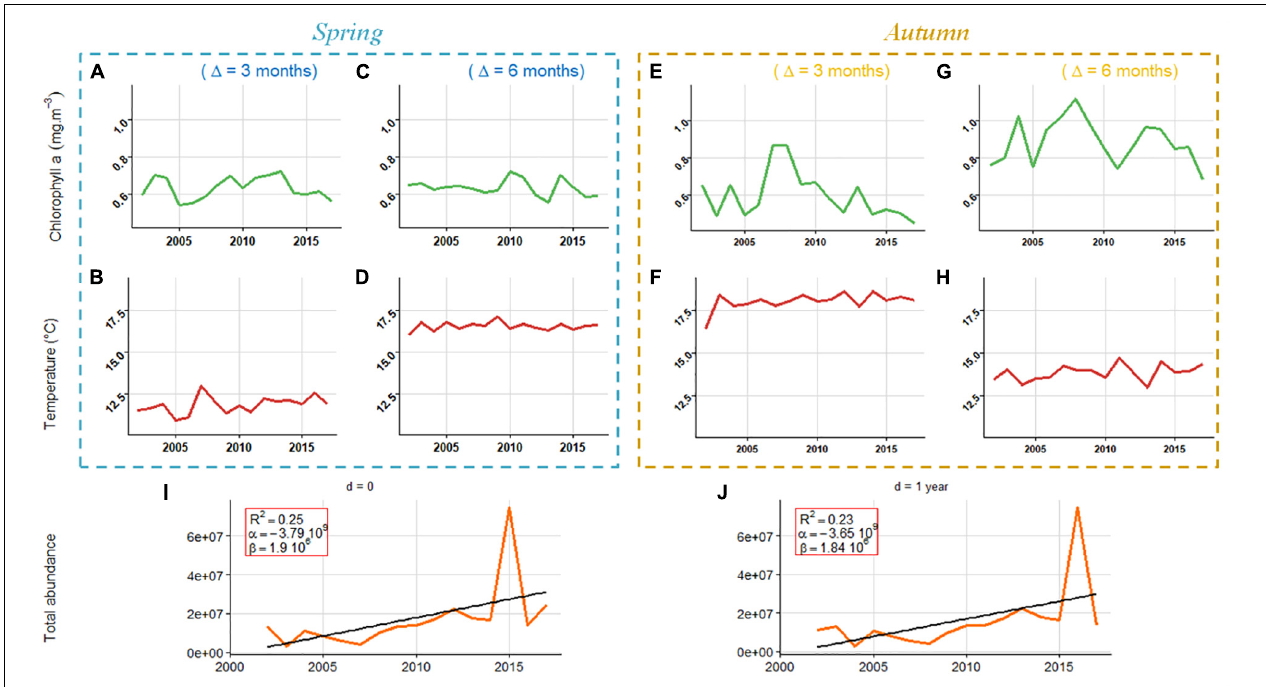
FIGURE 5 | Time series of environmental factors and abundance. The blue box show chlorophyll a and temperature considered for spring time analysis with a lag of three ( (cid:49) = 3 months) or six ( (cid:49) = 6 months) months before the spawning peak (A–D) while the yellow box correspond to those variables used when analyzing autumn reaction norm midpoints (E–H) . (I,J) correspond respectively to the total fish abundance the year and the year prior to the computation of reaction norm. Black lines are regression lines whenever a significant time trend at the 5% α -risk is found. TABLE 4 | Regression coefficients and their standard errors (SE) obtained from Eq. (7). Spring Effect Coefficient (SE) F p -value (F) (cid:49) Lp50 Long-term trend